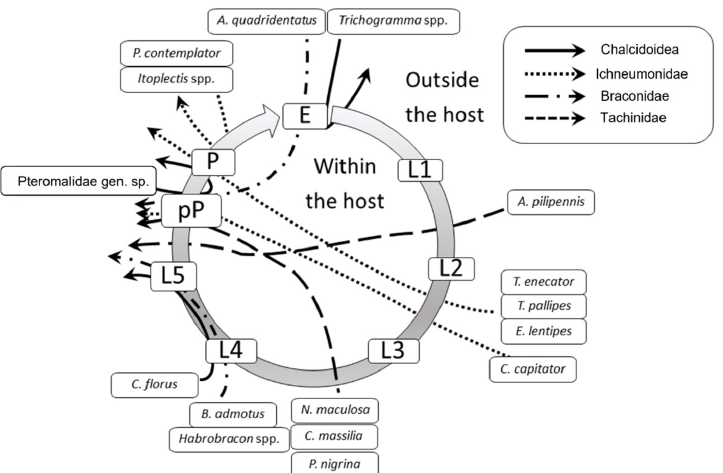
Figure 5. Parasitoids attacking different Lobesia botrana (EGVM) instars on Daphne gnidium sprouts in Tuscany, Central Italy. The grey circle represents the EGVM development. E: egg; L1-L5: I–V larval stages; pP: prepupa; P: pupa. Arrows connect the host stage attacked to the host stage killed by the parasitoid. Arrows passing through the host circle indicate an endoparasitic development, whereas those remaining outside the circle indicate an ectoparasitic development.